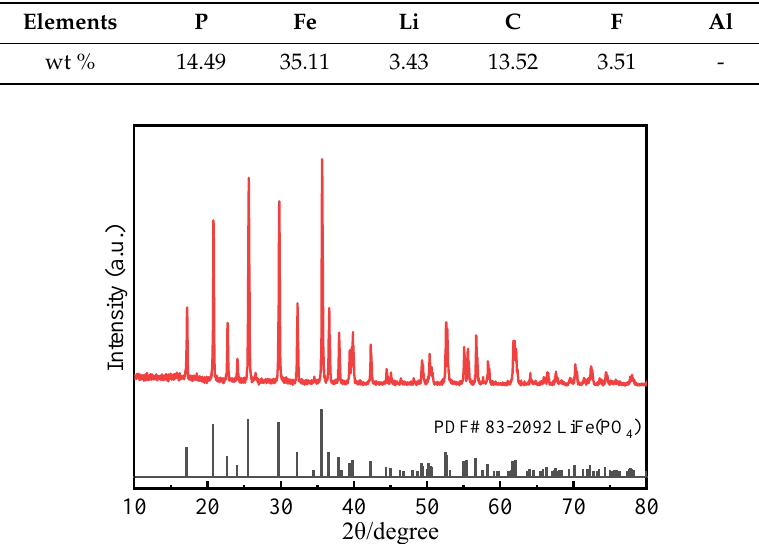
Table 1. Chemical composition of raw cathode materials.